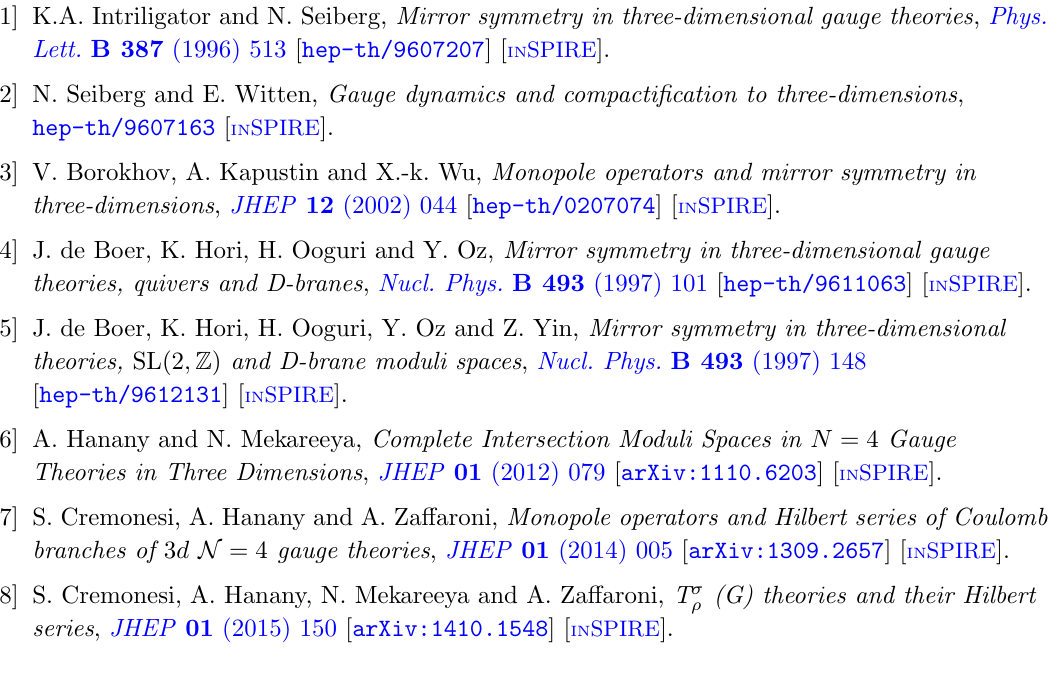
denotes the scalar of the U(1) f ( i ) m i is e